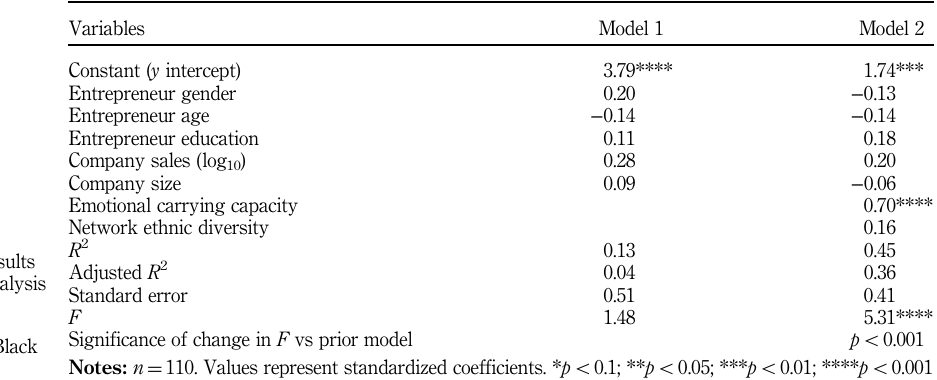
of regression analysis to predict entrepreneurial self-efficacy of white entrepreneurs